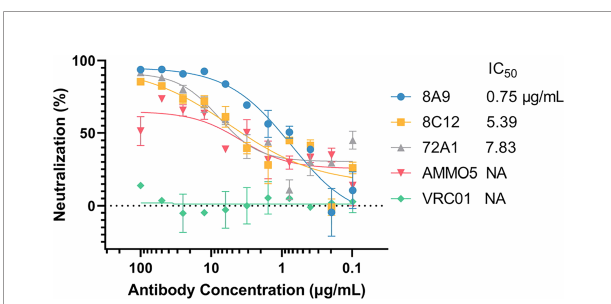
FIGURE 2 | Evaluation of the neutralizing abilities of 8A9, 8C12, and AMMO5. The neutralizing abilities of MAbs were measured in the B-cell infection assay. The MAbs were serially diluted and the IC 50 was calculated. VRC01 was used as the negative